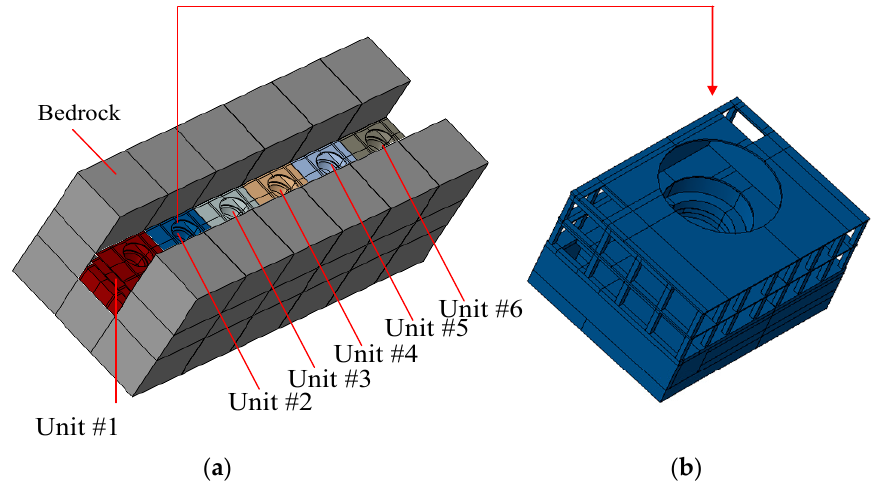
Figure 18. Finite element model: ( a ) Model of whole powerhouse; ( b ) Model of single unit.